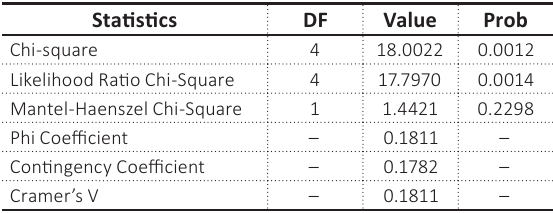
Table 5. Dependence between the decisive